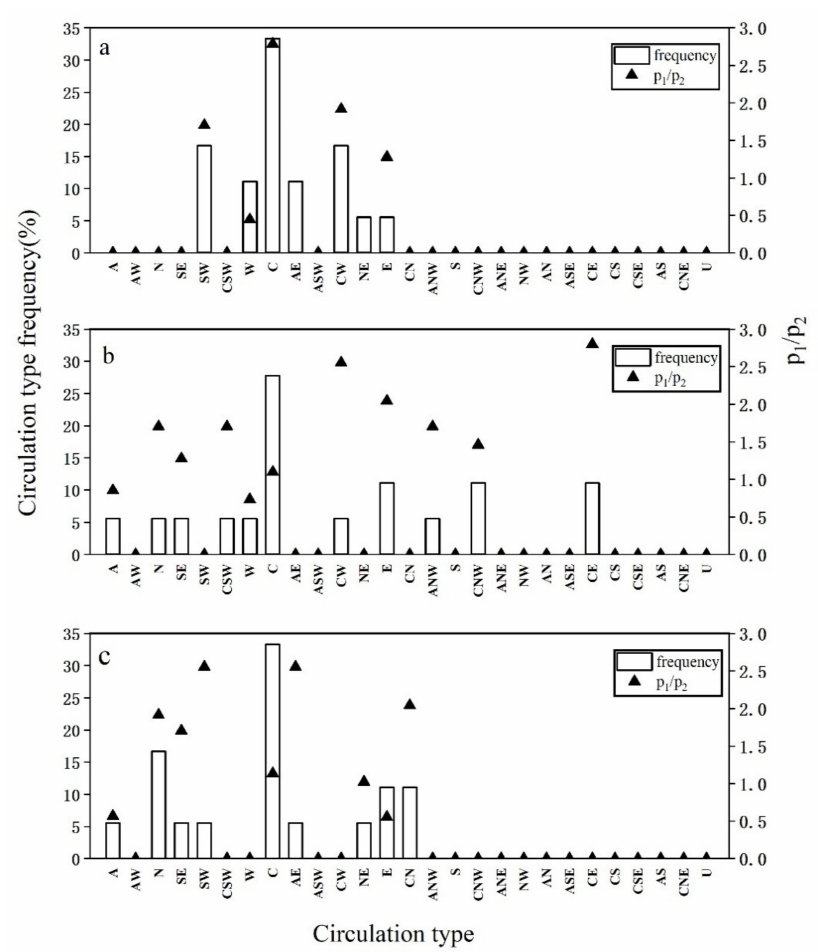
Figure 8. Frequency of each circulation type, and the P 1 / P 2 ratio in ( a ) the southern Xinjiang basin, ( b ) western Inner Mongolia and southern Mongolia, and ( c ) the center of Inner Mongolia in the spring